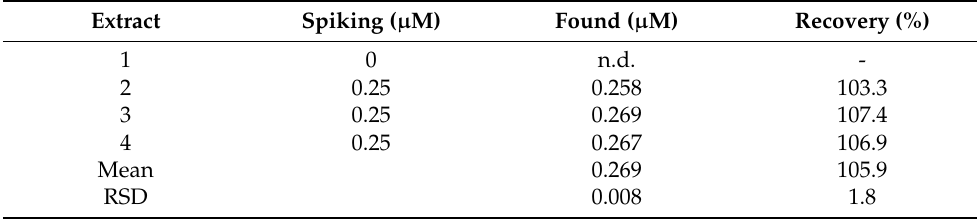
Table 3. Recovery assays in fish